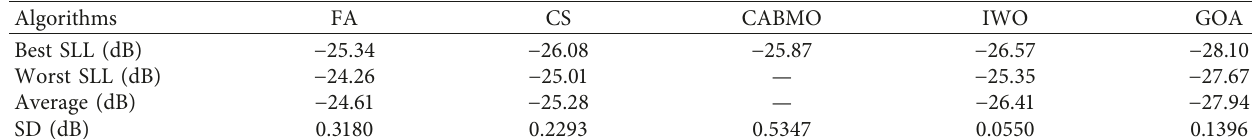
Table 7: The comparison of algorithms’ performance for 16-element linear array in 20 runs.